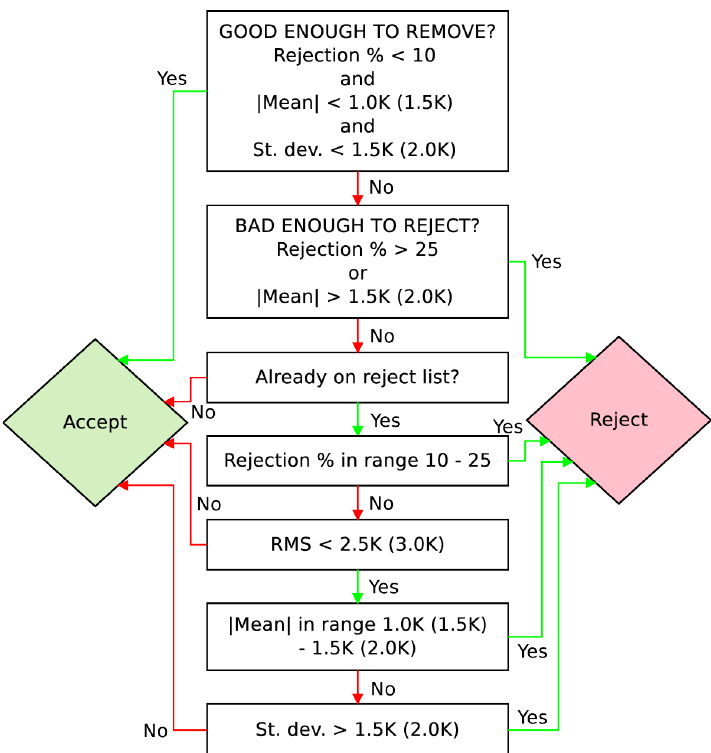
Figure 2. Decision process for determining if an in situ platform is added to or removed from a reject list. Decisions are based on the percentage of quality control rejections in the previous month and statistics of observation minus OSTIA differences. Buoy platforms and ships have different thresholds applied; the latter are given in